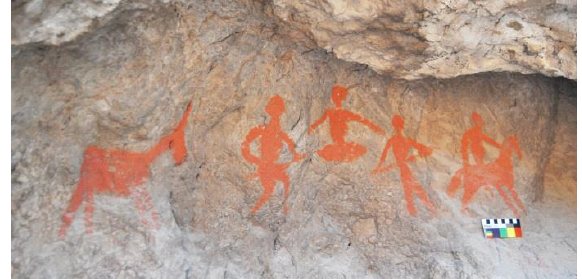
Figure 20. Site V. A group consisting of human shapes and a horse